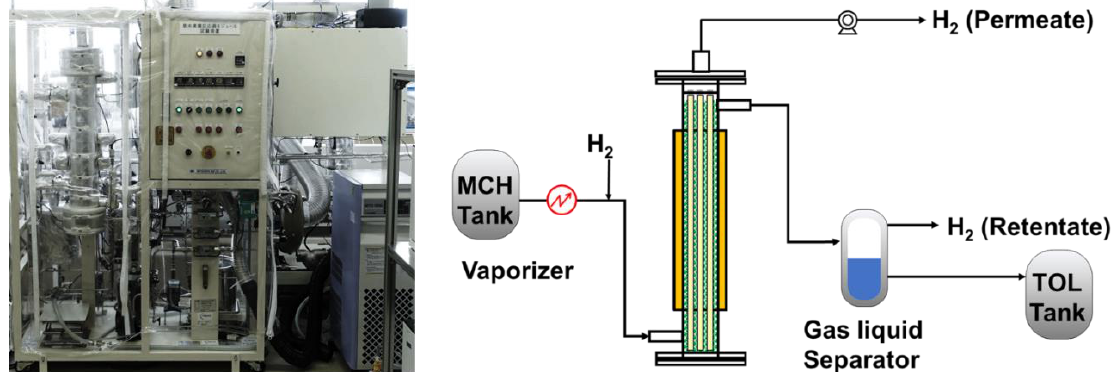
Figure 2. Picture and schematic diagram of small-scale membrane reactor for methylcyclohexane